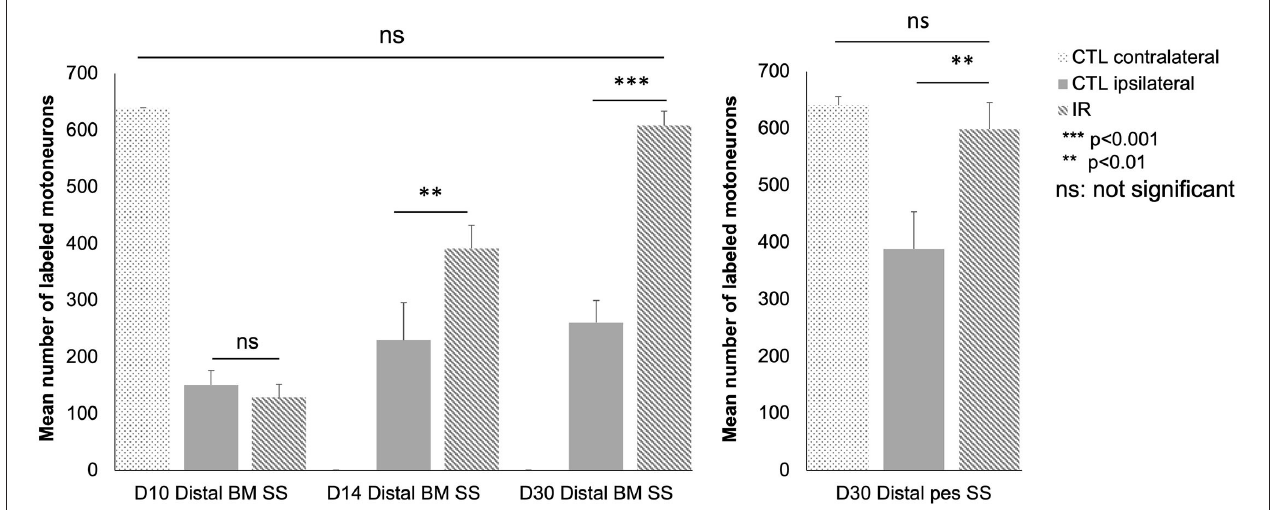
FIGURE 7 | Quantitative analysis of motoneurons in the lateral subnuclei of the facial complex as a function of time after surgery and treatment in the different groups: intact group ( n = 12), distal BM SS at D10, D14 and D30 control ( n = 36, 12 animals in each group) and treated animals ( n = 36, 12 animals in each group), and distal pes SS group at D30 [control ( n = 6) and treated animals ( n = 6)]. Note that at D10 only a few motoneurons are labeled. The number of labeled motoneurons increased progressively thereafter: by day 14, the mean number of labeled motoneurons is significantly higher (striped, gray column) in the IR-treated group than in the untreated group (gray column) ( p < 0.01). The number of labeled motoneurons returned to normal levels on day 30 in the treated mice but not in the untreated mice ( p < 0.001). Similar results were obtained for the distal pes SS group at D30 between control and treated mice ( p < 0.001). [* P < 0.05 ** P < 0.01 *** P < 0.001 ns P > 0.05; t